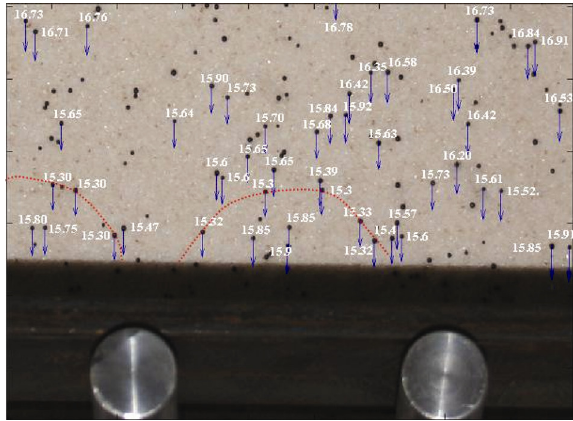
Fig. 13. Total soil surface displacements in mm due to soil arching with 18 mm box